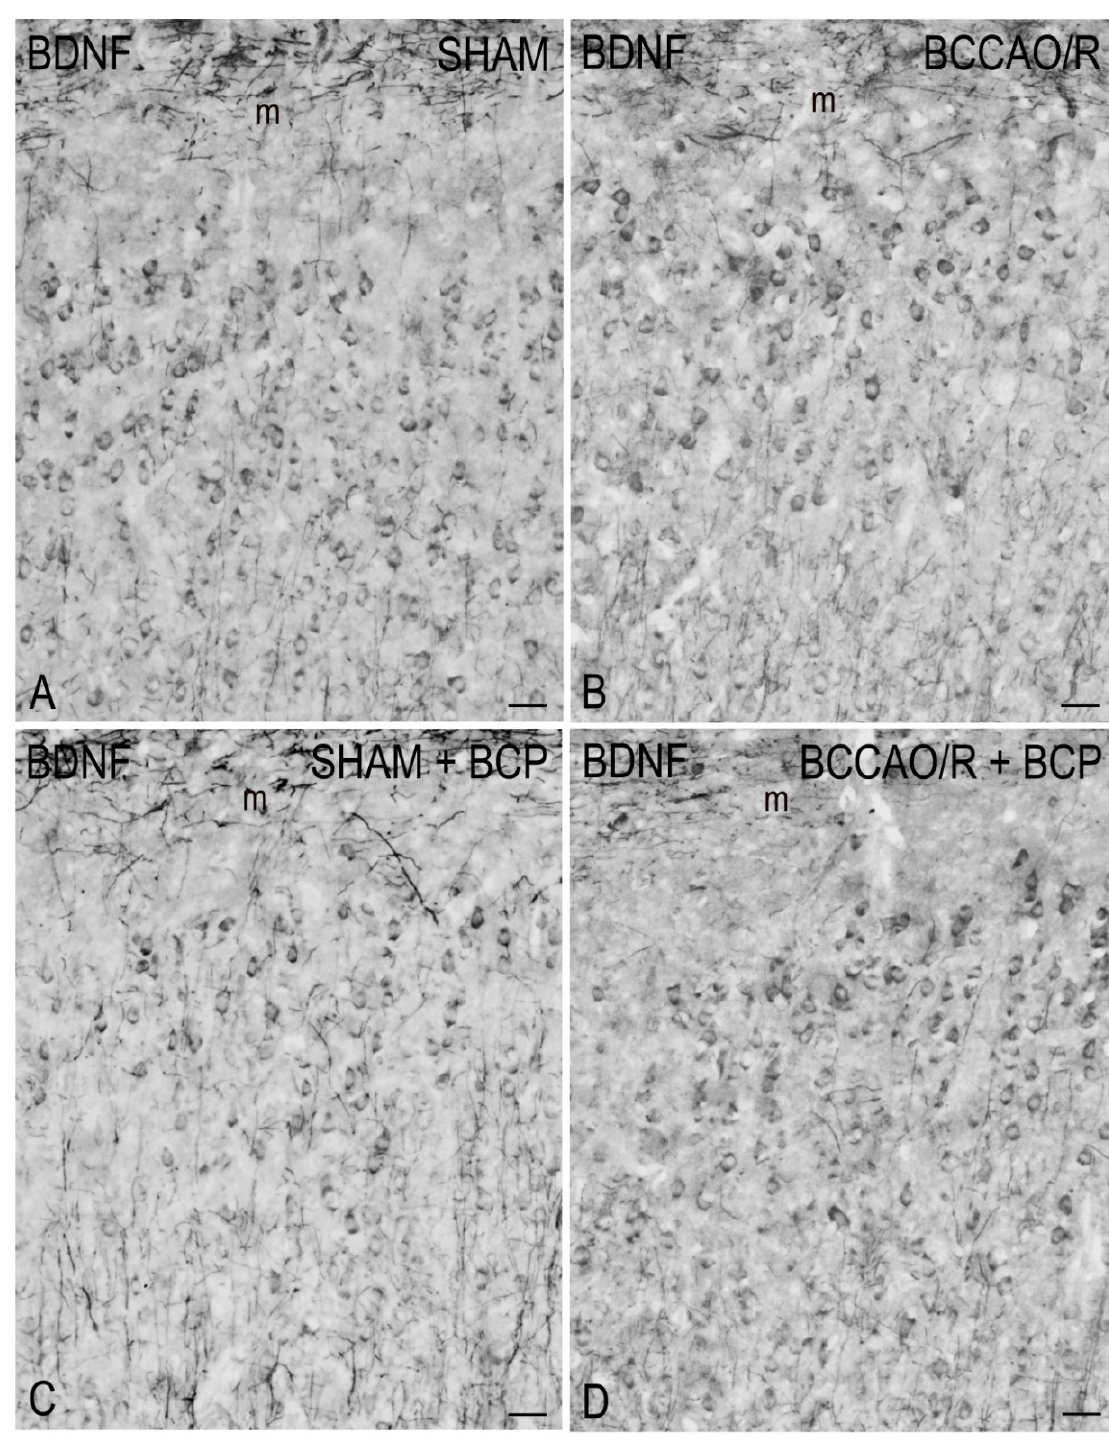
Figure 4. Brain-derived neurotrophic factor (BDNF)-like immunoreactivity in coronal sections of frontal cortex of sham-operated and bilateral common carotid artery occlusion followed by reper- fusion (BCCAO/R) rats, pre-treated with either the vehicle alone ( A , C ) or with beta-caryophyllene (BCP) ( B , D ). Immunoreactive neuronal perikarya, neuronal processes, and punctate elements are distributed across the whole thickness of the cortex. Arrows point to positive neuronal perikarya. Panels are representative of observations carried out in 6 rats for each group. m, molecular layer. Scale bars: 25 μ m.